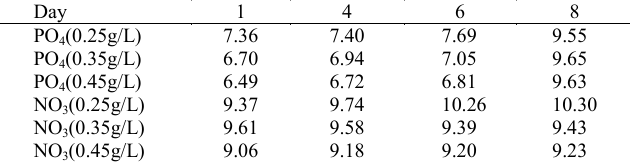
Table 4: pH changes in the culture of Chlorella vulgaris at various time intervals